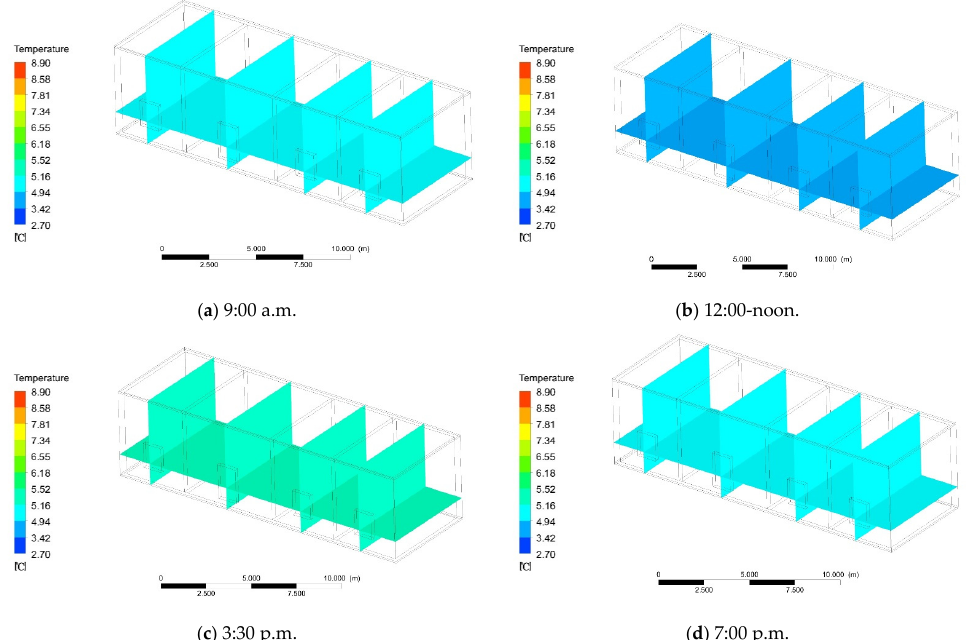
Figure 8. ( a ) At 9:00 a.m. the temperature of the ordinary heating (without WSR). ( b ) At 12:00-noon. the temperature of the ordinary heating (without WSR) ( c ) At 3:30 p.m. the temperature of the ordinary heating (without WSR). ( d ) At 7:00 p.m. the temperature of the ordinary heating (without WSR).